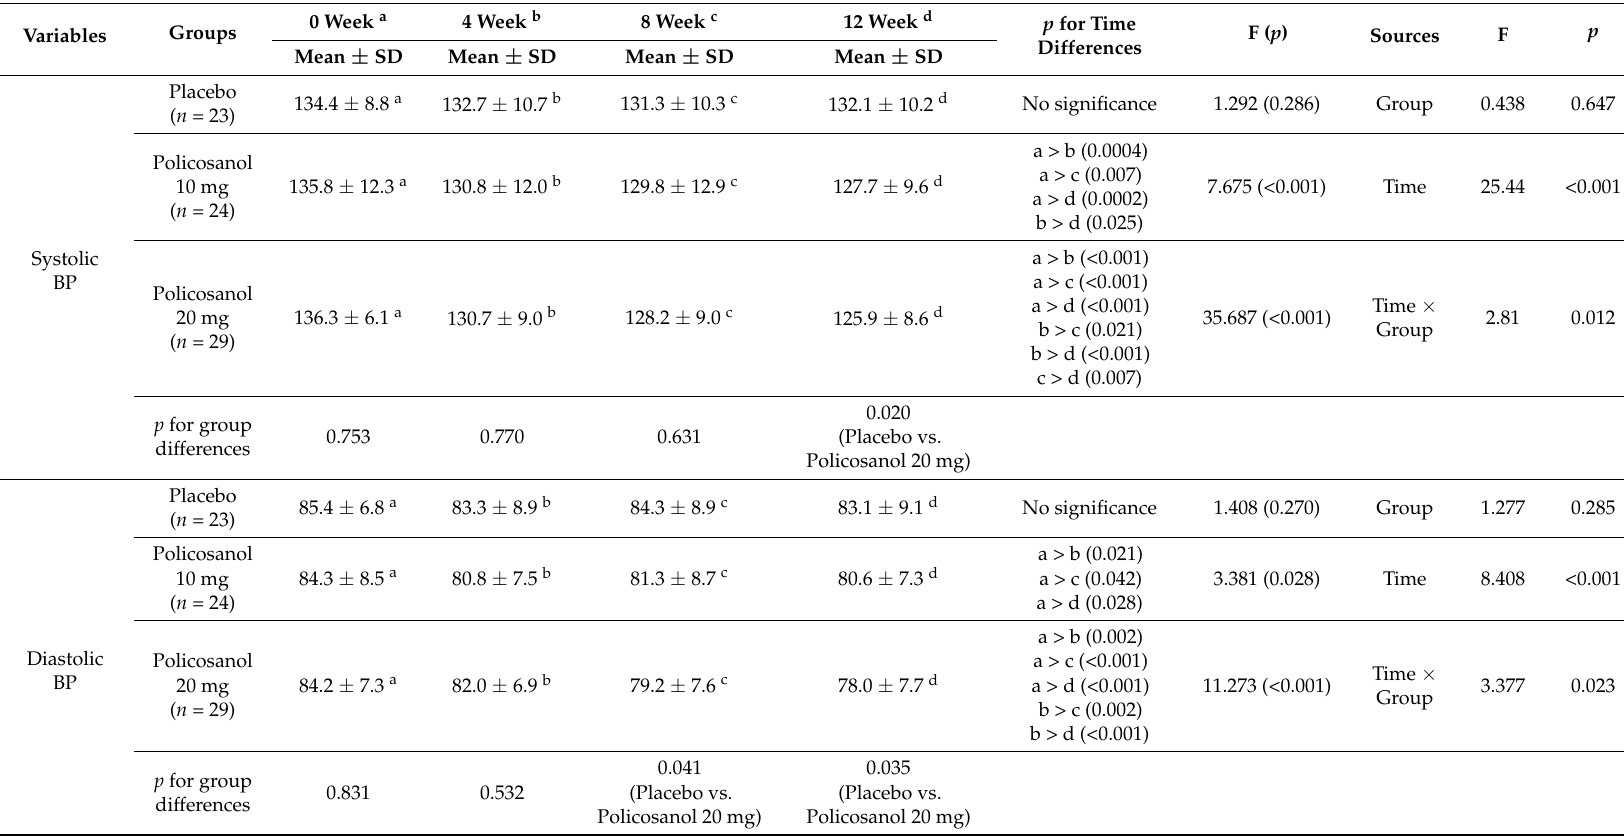
Table 3. Repeated measures ANOVA of peripheral systolic BP and diastolic BP between the three